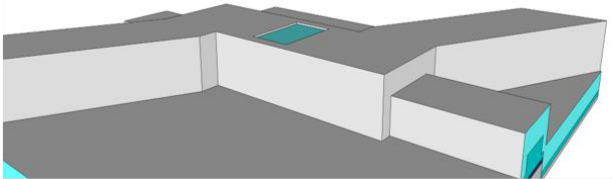
Figure 6. A close-up view of the window for top-illumination. A layer of aluminum is deposited over the whole device, and a window is milled through the aluminum, leaving the transparent oxide exposed.